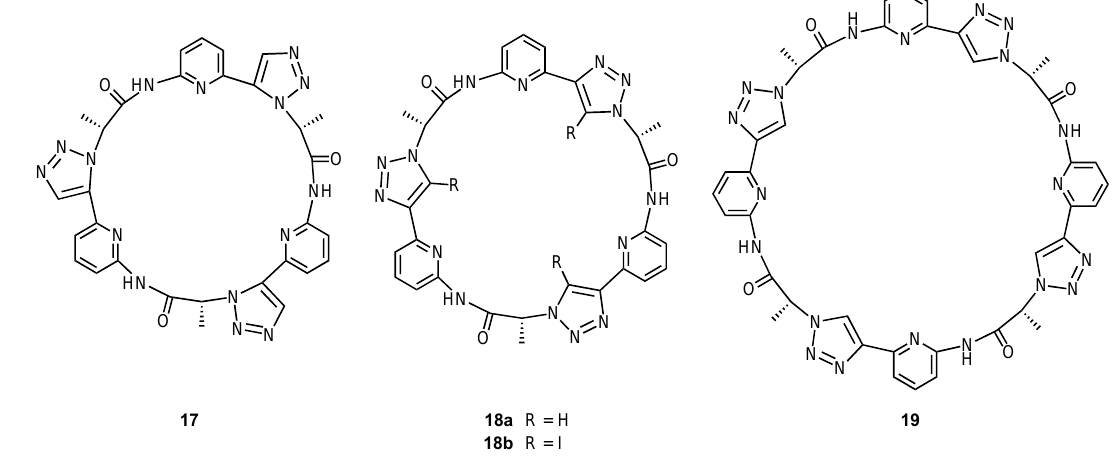
Scheme 6. Structures of the cyclic pseudopeptides 17 – 19 .